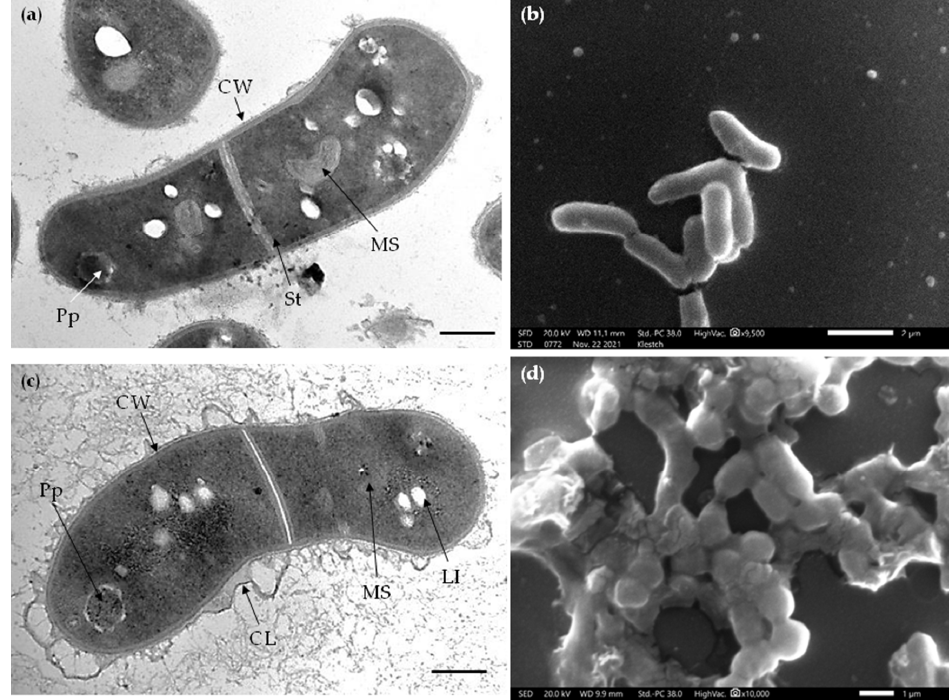
Figure 6. TEM images of ultrathin sections ( a , c ) and SEM images of whole cells ( b , d ) of R. rhodo- IEGM 757 grown in the control medium ( a , b ) and in the presence of OA ( c , d ). Designations: CL, capsular layer; CW, cell wall; Pp, polyphosphate granules; LI, lipid inclusions; MS, membrane-like structures; St, cell division septa. Bars: ( a , c ) 200 nm; ( b ) 2 µ m; ( d ) 1 µ